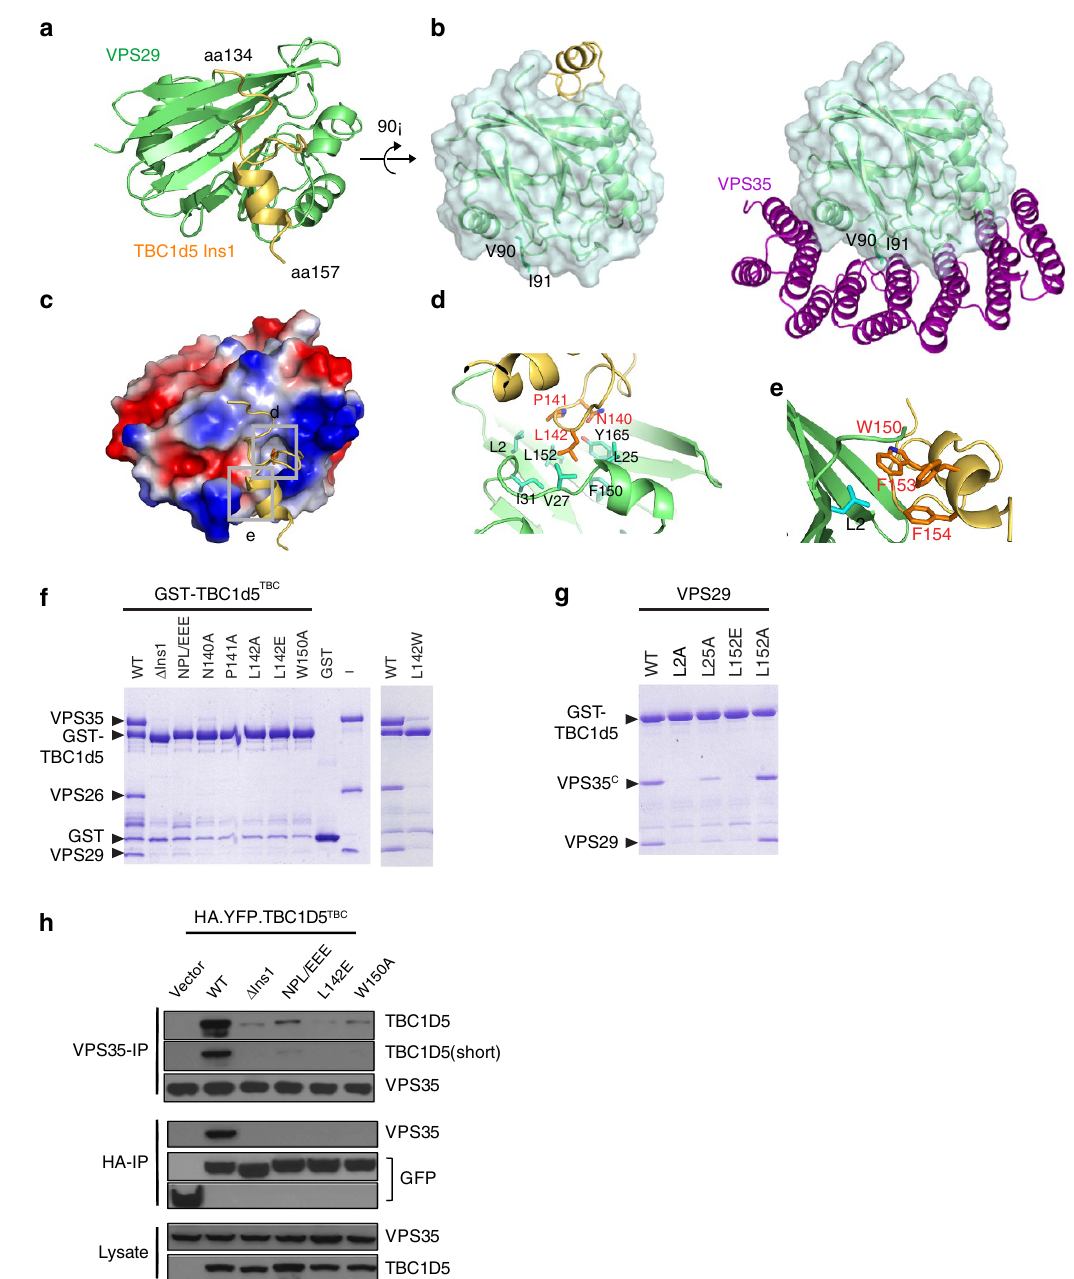
Figure 2 | Interaction between VPS29 and TBC1d5. ( a ) Ribbon diagram of the VPS29/TBC1d5-Ins1 complex (VPS29: green; Ins1; yellow). ( b ) Structural comparison of VPS29/TBC1d5-Ins1 and VPS29/VPS35 C . VPS29 is shown as same orientation in two structures and is 90 (cid:2) rotation about a horizontal axis from a . (VPS35 C : magenta). ( c ) GRASP surface charge distribution (blue for positive, red for negative, white for neutral). The Ins1 is shown as stick models. The structure is shown as same orientation as a . ( d , e ) VPS29-TBC1d5-Ins1 interactions in detail. Critical VPS29 and TBC1d5-Ins1 residues are shown in stick modes. ( f , g ) Coomassie blue stained SDS–PAGE gels of eluted proteins are shown. In f , immobilized GST–TBC1d5 TBC WT but not mutants ( D Ins1, NPL/EEE, N140A, P141A, L142A, L142E, L142Wand W150A) selectively retained CSC. In g , mutation on VPS29 surface residues had various effects on the interaction between GST–TBC1d5 TBC and VPS35 C /VPS29. ( h ) TBC1d5 TBC WT, but not D Ins1, NPL/EEE, L142E and W150A, co-immunoprecipitated with VPS35. Hela cells were transfected with yellow fluorescent protein (YFP) or various YFP–TBC1d5 (green) and immunoprecipitate with anti-VPS35 or anti-HA antibodies. Lysates were immunoblotted as a